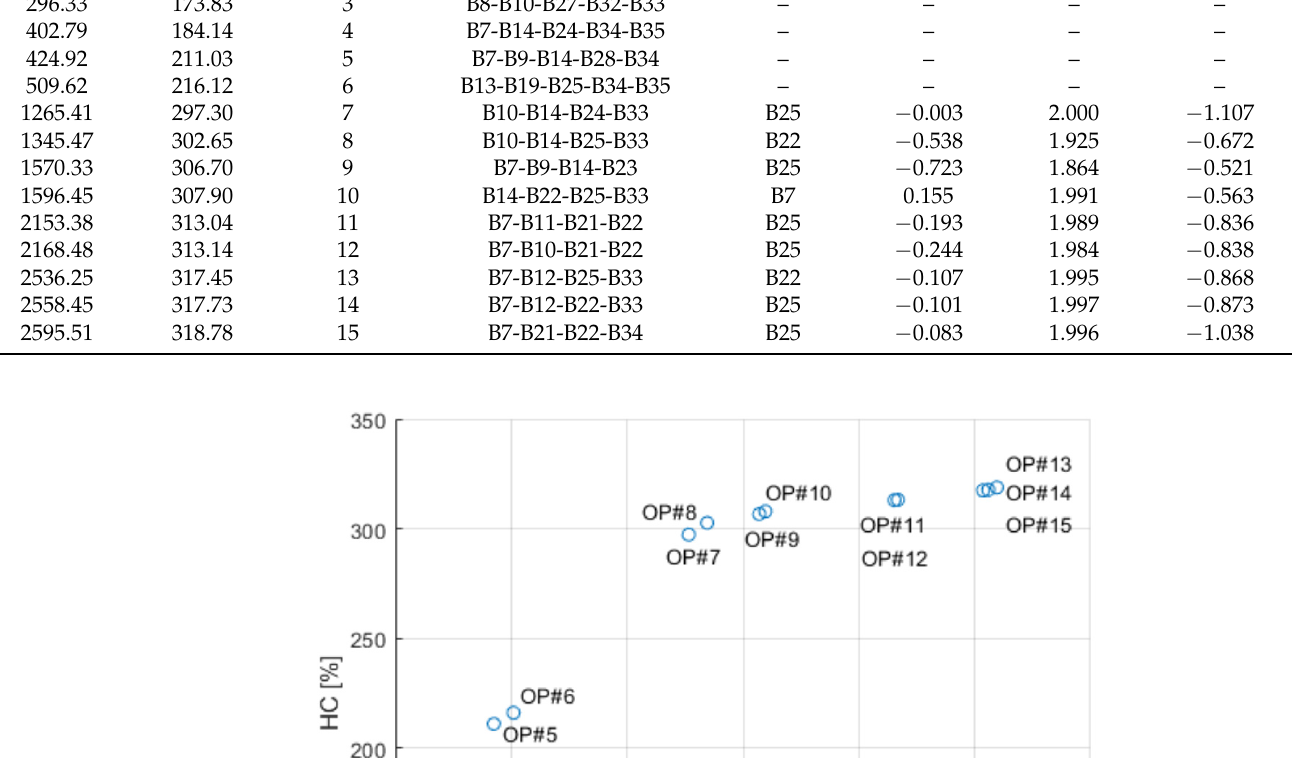
Figure 8. Dispersion of the MOAIS simulations, Case 1.